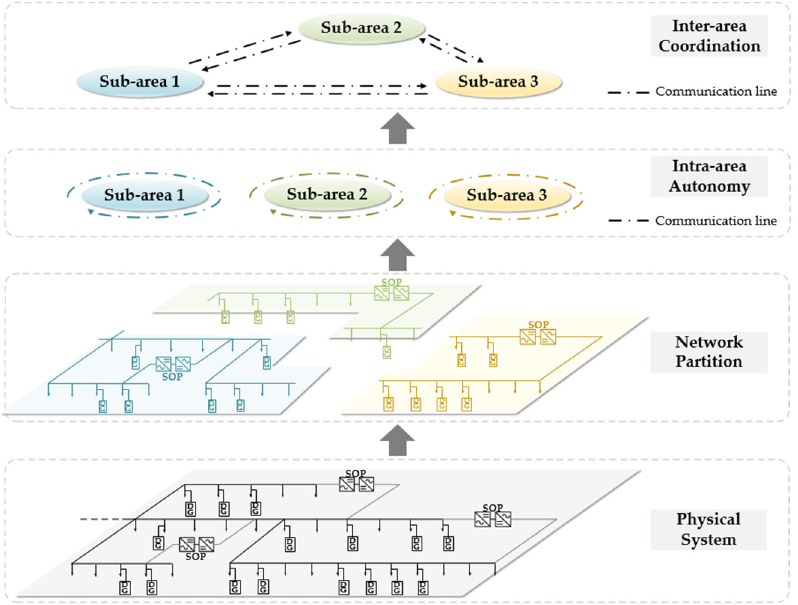
Figure 1. Decentralized control framework of SOPs.